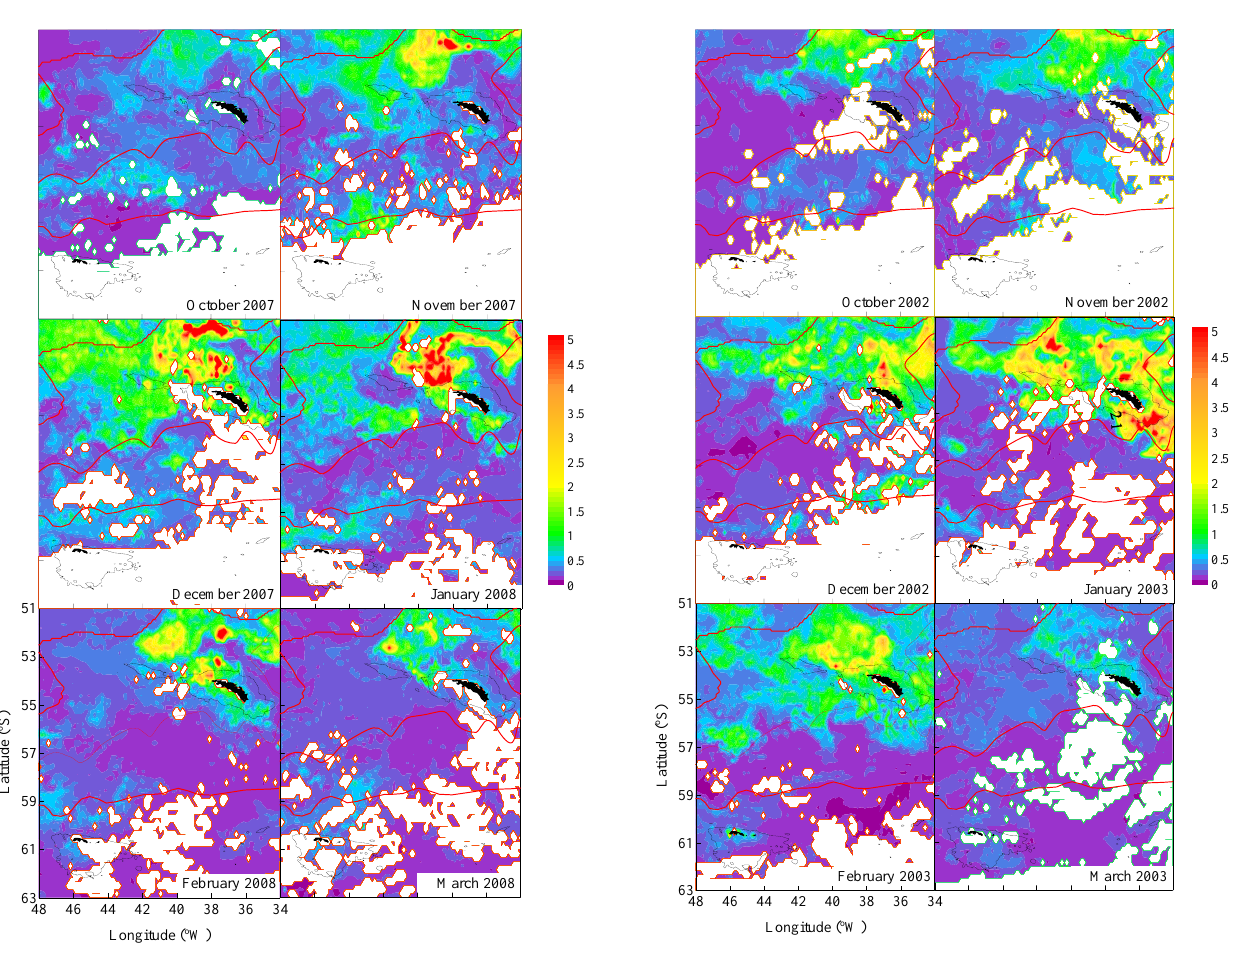
Fig. 5. Monthly composites of MODIS-Aqua Chl a concentrations (mgm − 3 ) in the Scotia Sea from October 2007 to March 2008. White areas indicate clouds and/or sea-ice. Frontal positions are marked as thin red lines.